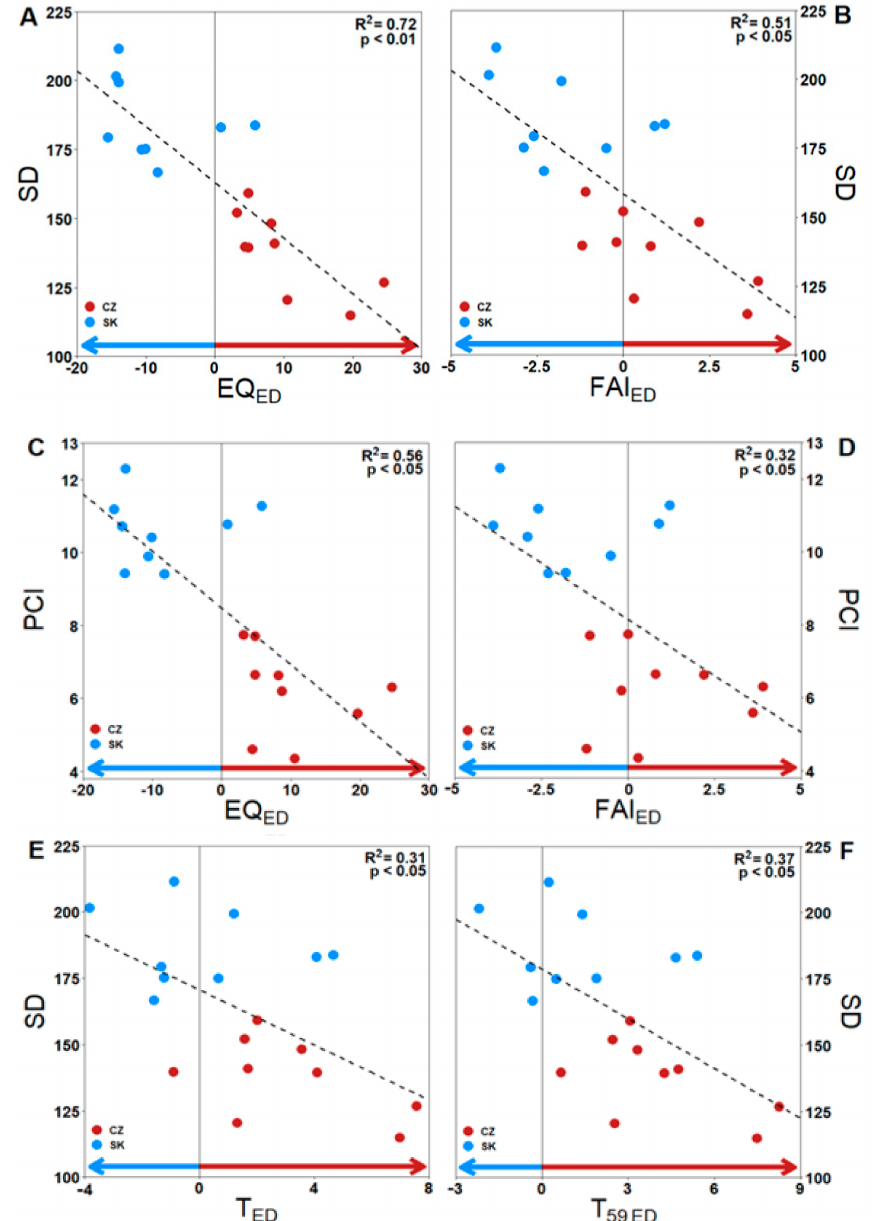
Figure 3. Linear regression results showing the relationship between ecodistance ( EQ ED , FAI ED , T ED , T 59 ED ) and stomatal morphological traits, stomatal density ( SD , ( A , B , E , F )) and the potential conductance index ( PCI , ( C , D )). Positive values on the horizontal axis represent transfer to a drier / hotter environment (red arrow), and negative values represent transfer to a more humid / colder environment (blue